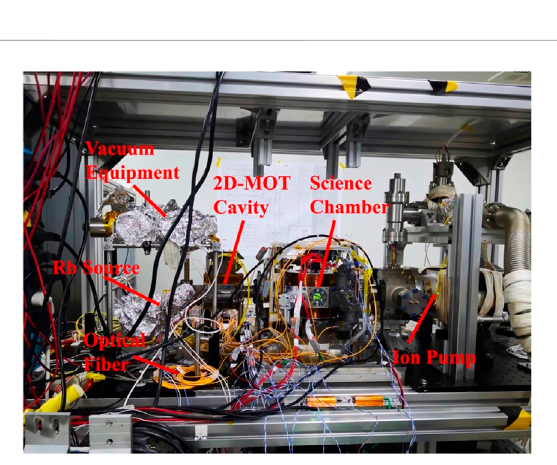
FIGURE 3 Pre-prototype for CAPR (2D-MOT and 3D-MOT parts). The sizeisalmostsameoftheformalone.Alllasertransmissionsonthe pre-prototype use optical fi ber, which is different from the space optical path transmission on the ground-based prototype. Various tests are also carried out on the pre-prototype to make reference and backup for the real launched